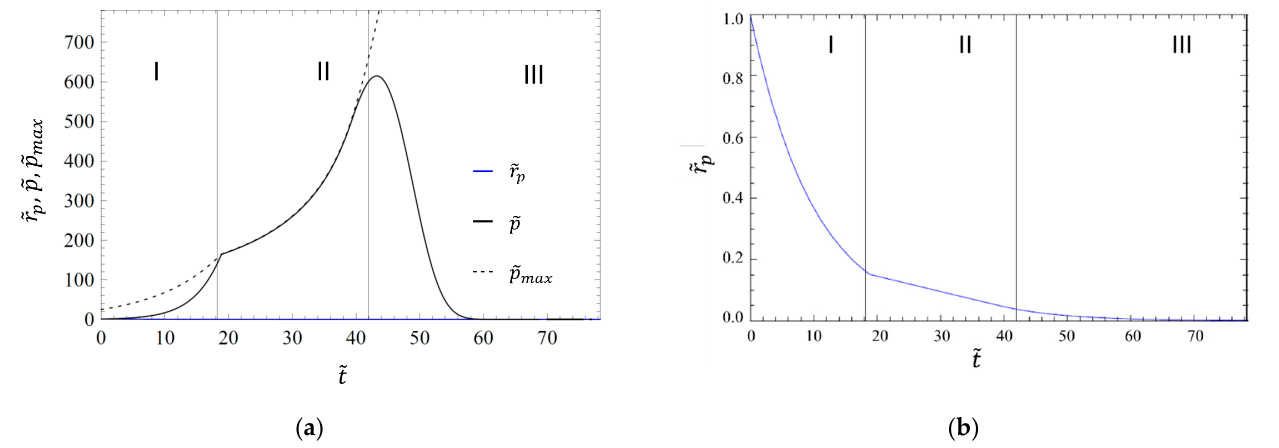
Figure 5. Radius 𝑟̃ (cid:3043) (in blue), gas pressure 𝑝(cid:3556) = 𝑝/𝑝 (cid:2868) in the pore (in black) and maximum gas pressure 𝑝(cid:3556) (cid:3040)(cid:3028)(cid:3051) above which Figure 5. Radius (cid:101) r p (in blue), gas pressure (cid:101) p = p / p 0 in the pore (in black) and maximum gas pressure (cid:101) p max above which the pore will expand (dashed black), as a function of dimensionless time 𝑡̃ for the transfer coefficient model with 𝑔(cid:3556) = the pore will expand (dashed black), as a function of dimensionless time (cid:101) t for the transfer coefficient model with (cid:101) g = 0.01, 0.01 , 𝑟̃ (cid:3043),(cid:3032)(cid:3044) = 0.2 and 𝜆(cid:4634) = 5 (plot ( a )). Magnification of the blue curve for 𝑟̃ (cid:3043) versus 𝑡̃ from ( a ) (plot ( b )) (adapted from (cid:101) r p , eq = 0.2 and (cid:101) λ = 5 (plot ( a )). Magnification of the blue curve for (cid:101) r p versus (cid:101) t from ( a ) (plot ( b )) (adapted from [12]).